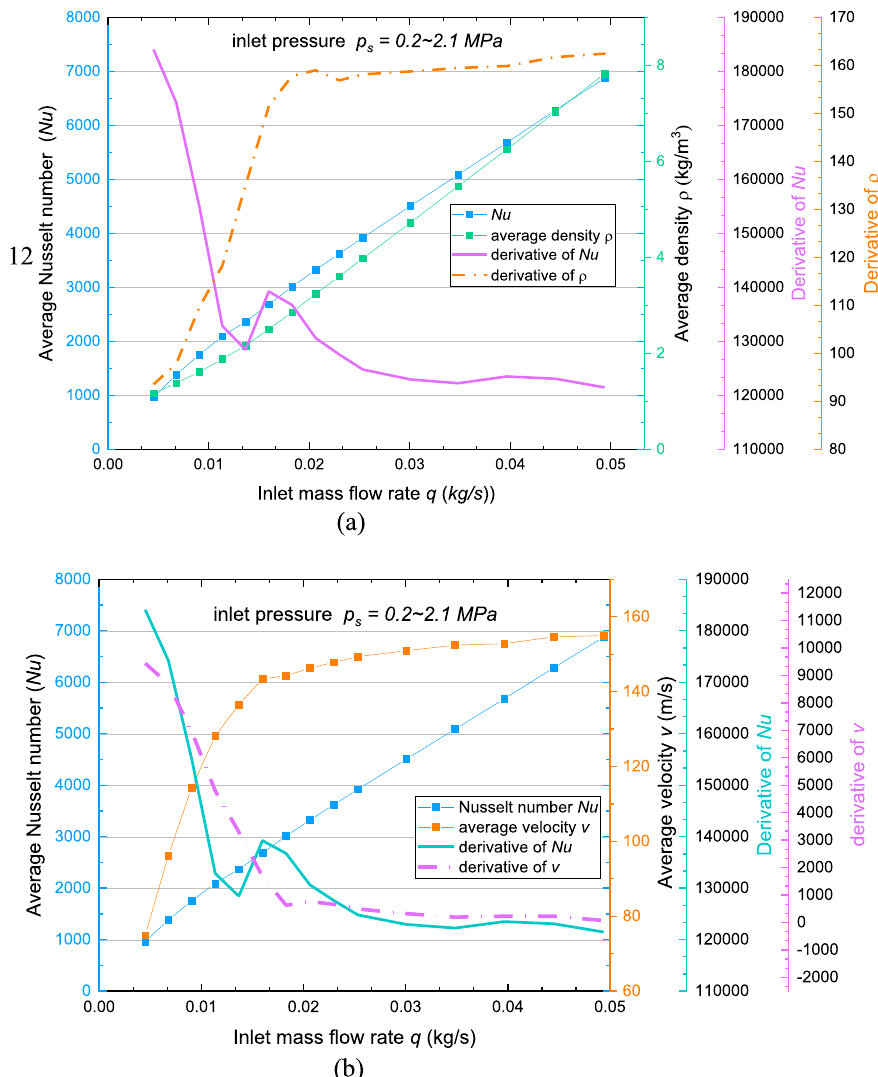
Fig. 18. Comparison of the average Nusselt number between density effect and velocity effect with different inlet pressure, H=0.2 mm, di=2 mm, po=0.1 MPa. (a) Average Nusselt number Nu vs fl uid density r, (the raw data are attached in Tab. A1). (b) Average Nusselt number Nu vs fl ow velocity v. (the raw data are attached in Tab. A2).